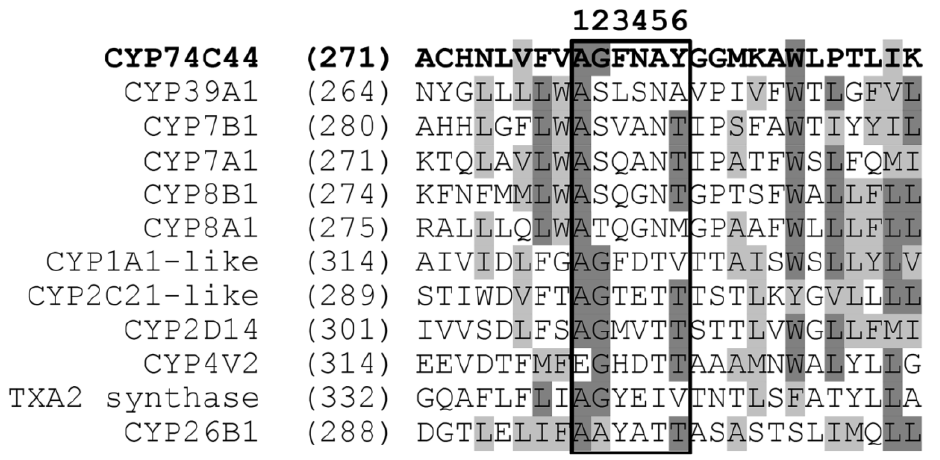
region, SRS-4). The I-helix groove motifs are framed.